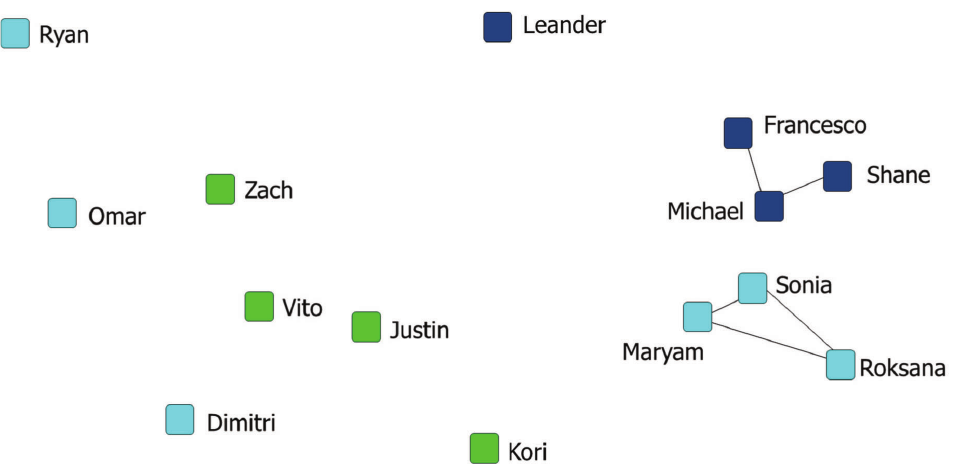
Figure 1: Reciprocal friendship network of the Strings B group during the first wave of quantitative measurements, before the music programme started (colours indicate the school classes of the